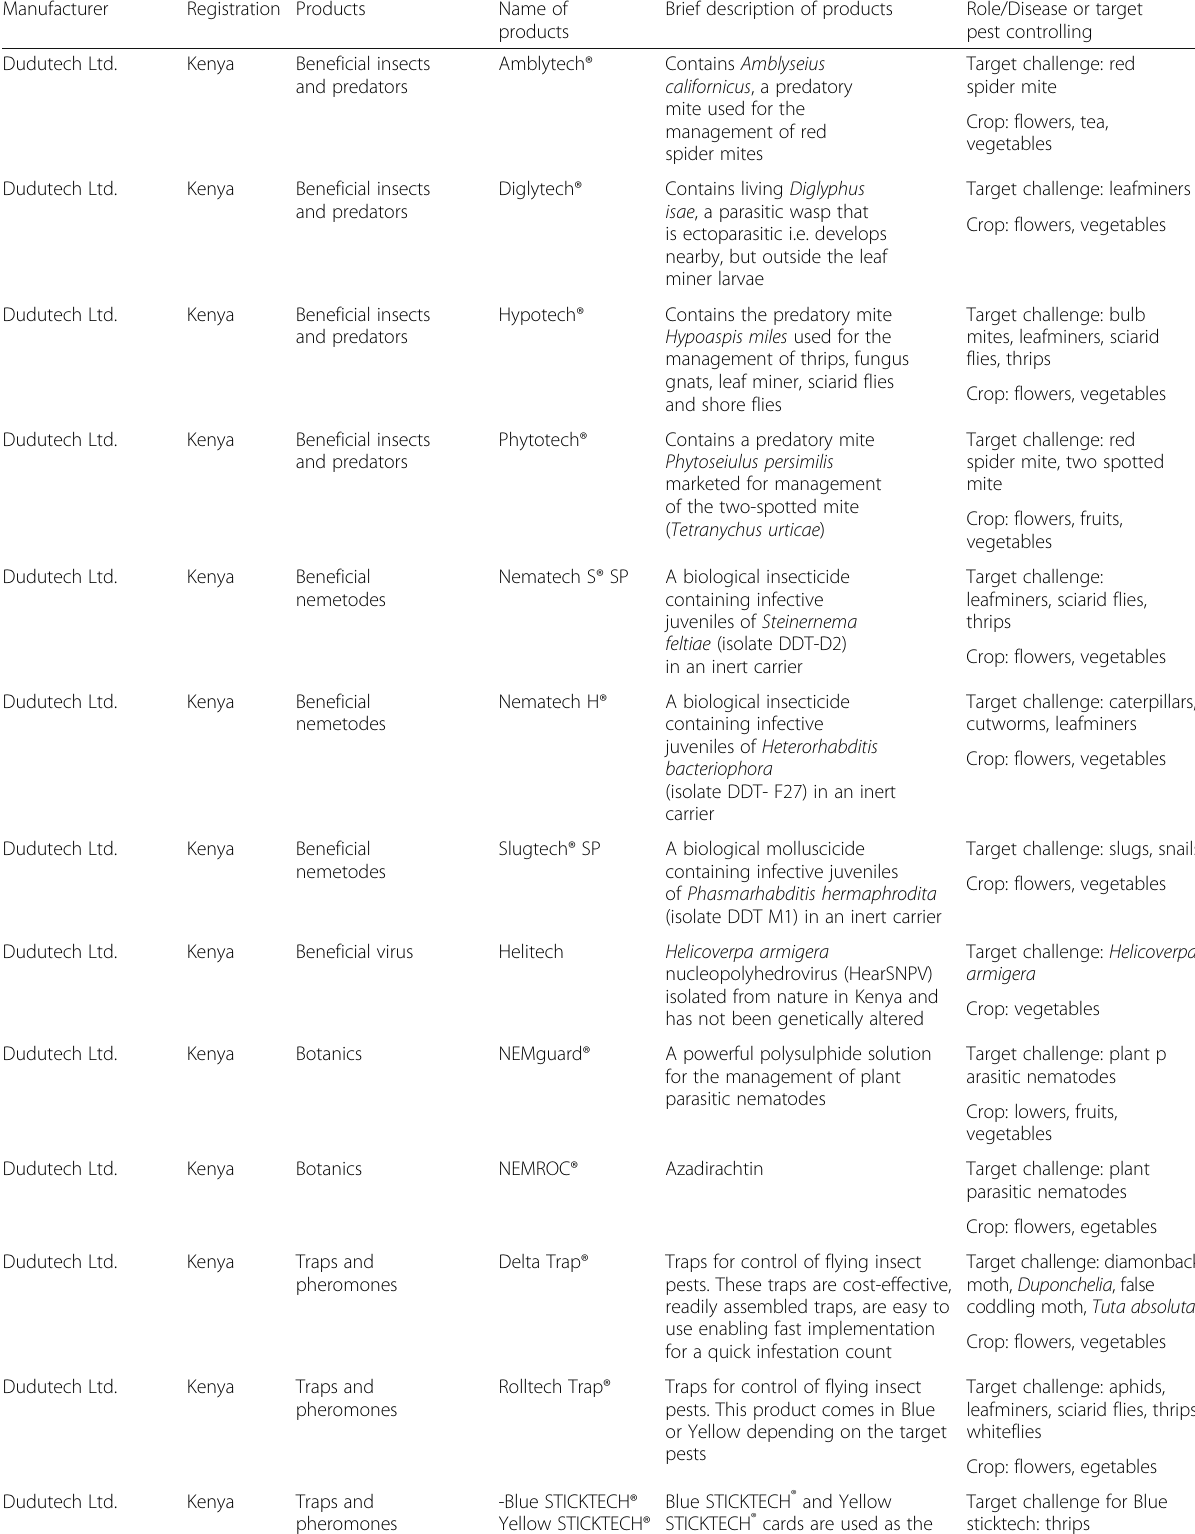
Table 2 Presentation of manufacturers in Africa and commercialized products